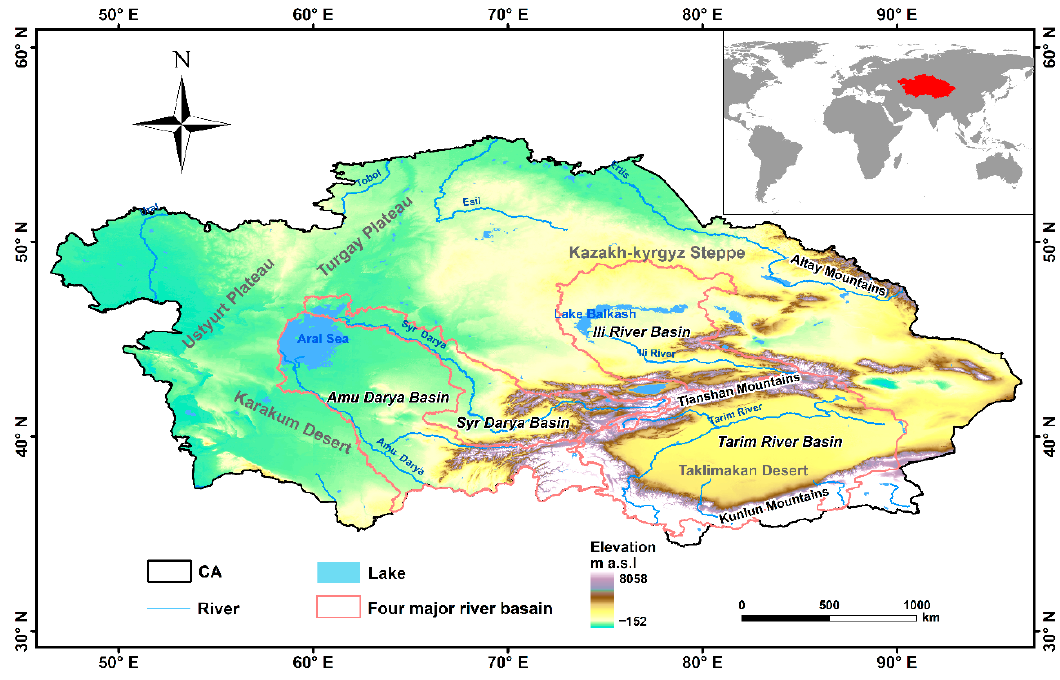
Figure 1. Geographical location of major basins in Central Asia.